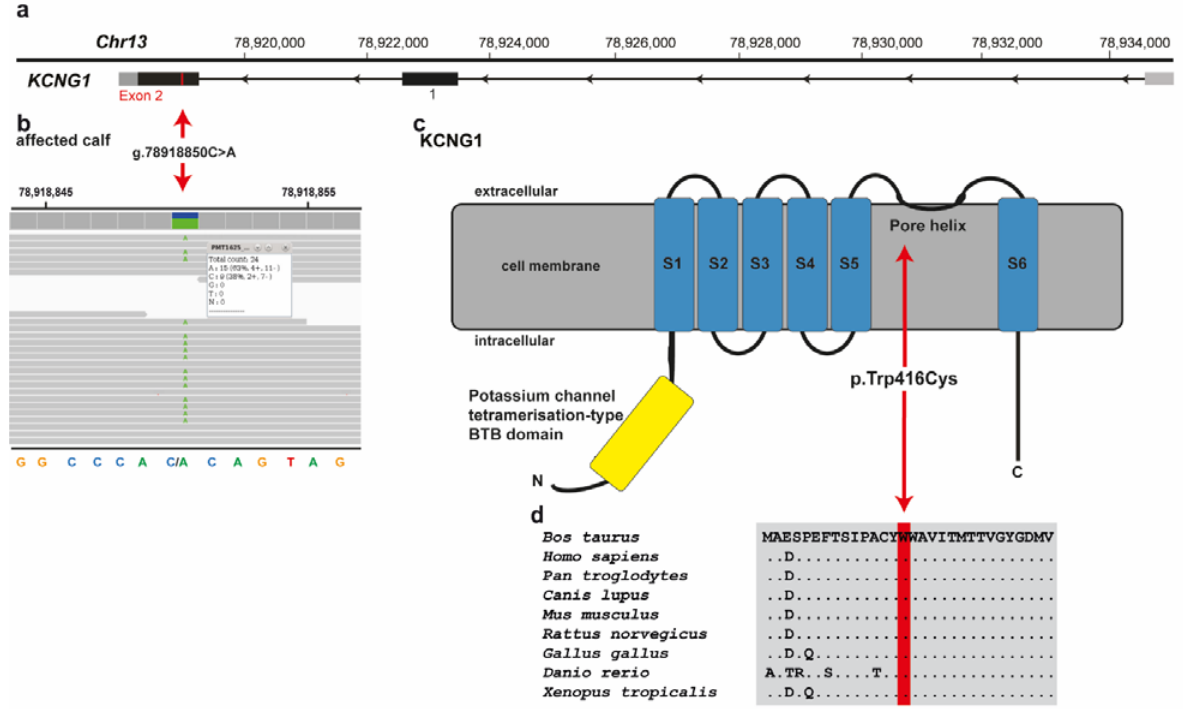
Figure 4. KCNG1 missense variant in a crossbred calf with paradoxical myotonia congenita and myelodysplasia. ( a ) Structure of KCNG1 showing the exon 2 variant located on chromosome 13. ( b ) IGV screenshot presenting the Chr13: 78918850C>A variant in the affected calf. ( c ) Schematic representation of KCNG1 protein and its functional domains with the position of the identified pathogenic variant (red arrow). The six transmembrane domains are shown in blue (S1-S6). ( d ) Cross-species sequence comparison of the ion transport domain of the KCNG1protein with the region around the p.Trp416Cys variant shows complete evolutionary conservation.